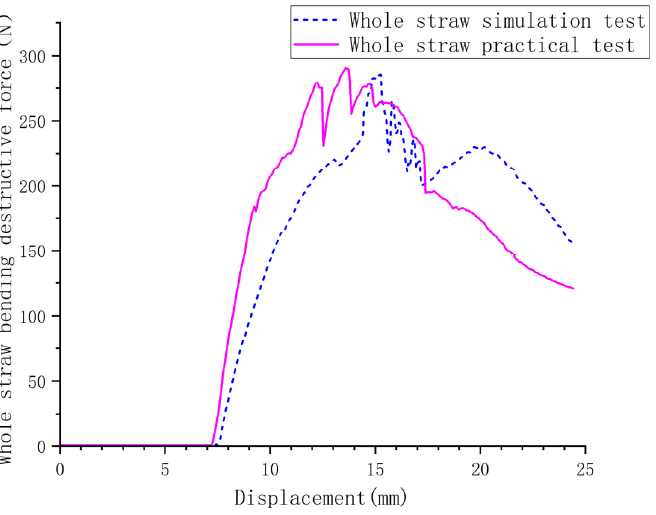
Figure 17. Comparison of bending damage force results for whole